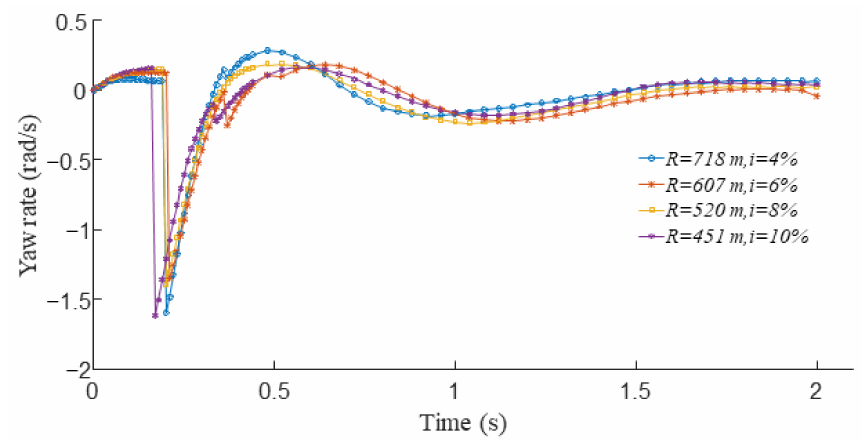
Figure 7. Simulation results of the yaw angular velocity at a driving speed of 120 km/h.